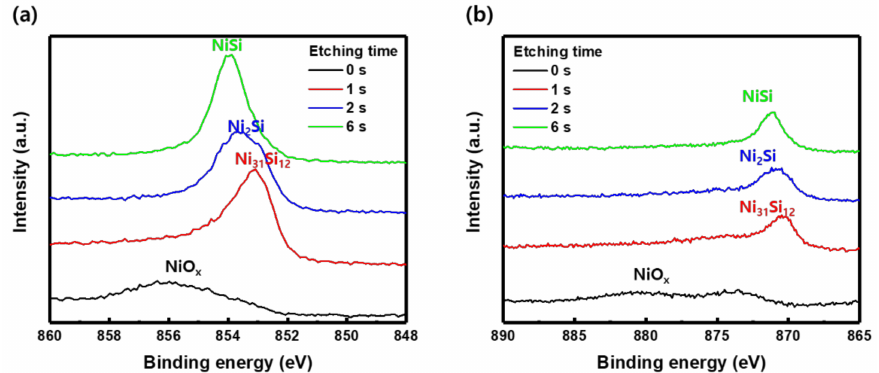
Figure 7. XPS depth profiling of 5 nm thick NiO x thin film on n + poly-Si ( a ) Ni 2p 3/2 and ( b ) Ni 2p 1/2 according to Ar + etching